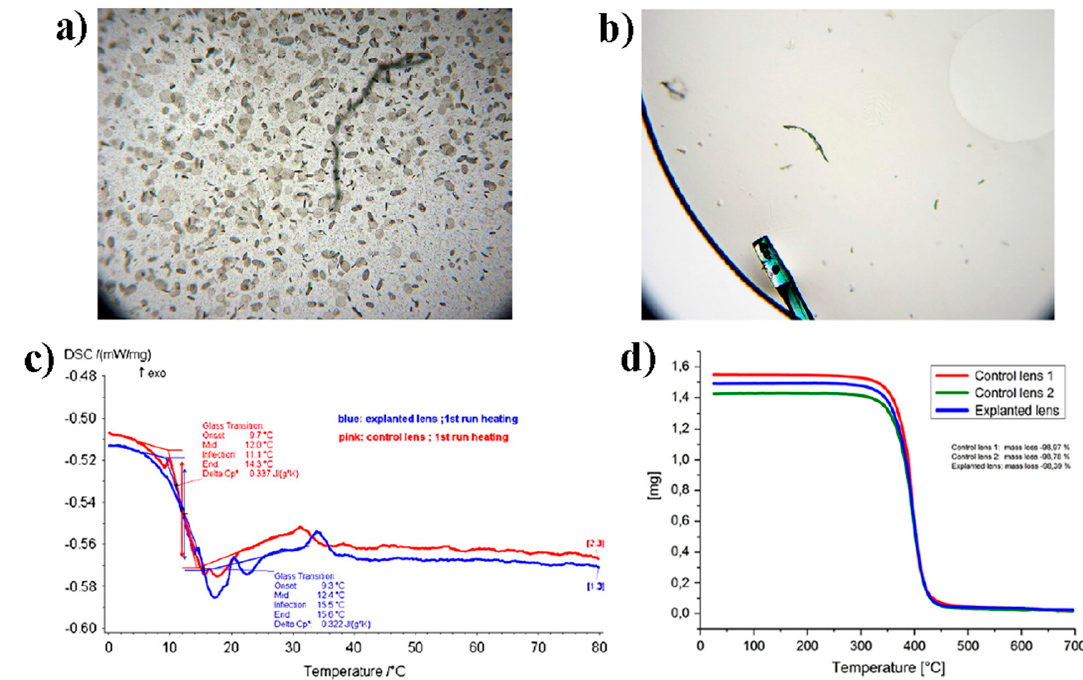
Figure 12. Comparison between two IOLs made of hydrophobic acrylic. ( a ) Light photomicrographs at 40x magnification showing intra-optic glistening for an IOL explanted from a patient 26 days after implantation. ( b ) Same as ( a ) but for a control IOL kept in a balanced salt solution at 37 °C for 2 weeks showing only crystal-like deposits. ( c ) DSC curves for explanted and control IOLs for determination of Tg (about 12 °C in both cases), showing non-perfect overlap. ( d ) TGA curves showing very high stability for all IOLs; in this case, two control IOLs have been considered. Figure adapted with permission from Ref. [108]. L. Werner et al. Unusual Pattern of Glistening Formation on a 3-Piece Hydrophobic Acrylic Intraocular Lens. J Cataract Refract Surg 34: 1604–1609, 2008. © Wolters Kluwer Health, Inc., Philadelphia, PA, USA.